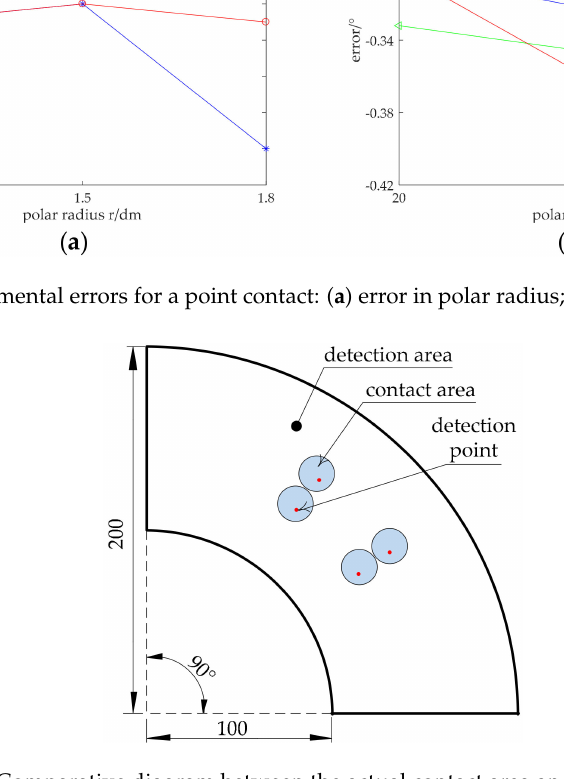
Figure 17. Comparative diagram between the actual contact area and detected points.